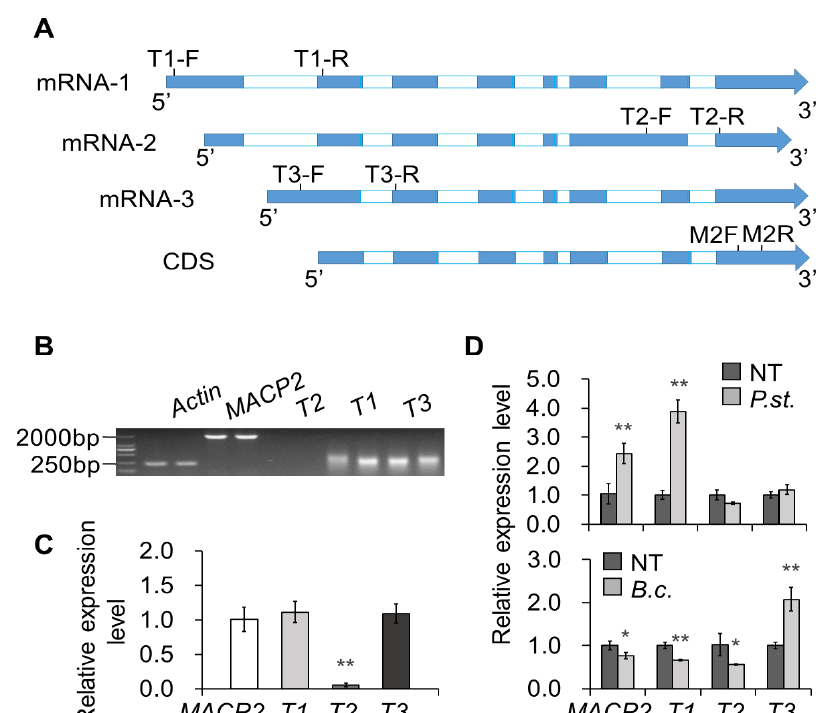
Figure 6. AS of MACP2 responded to fungal and bacterial pathogens. ( A ) Classification of three AS of MACP2 gene. The blue represents exons and white represents introns. ( B ) Semiquantitative PCR detection of full-length MACP2 and specific sequence of each AS (T1, T2, T3) in 4-week-old rosettes of wild-type. The full-length of MACP2 was amplified with primer pair XS2591 and XS2592. The specific sequences of AS were amplified with primer pairs MACP2-1 F/MACP2-1 R, MACP2-2 F/MACP2-2 R, and MACP2-3 F/MACP2-3 R, respectively. ( C ) qRT-PCR detection of common sequence (MACP2) and specific sequence of each AS (T1, T2, T3) in 4-week-old rosettes of wild-type. The common sequence of three AS was amplified with primer pair MACP2-F and MACP2-R. The specific sequences of AS were amplified with primer pair mentioned in ( B ). The ACTIN2 was amplified with primer pair ACTIN2-F and ACTIN2-R. Asterisks indicate significant differences from the wild-type. ** p < 0.01 by Student’s t test. ( D ) qRT-PCR detection of AS responding to Pst DC3000 and B. cinerea after 3 days of infection on 4-week-old rosettes of wild-type. Asterisks indicate significant differences from the wild-type. * p < 0.05, ** p < 0.01 by Student’s t